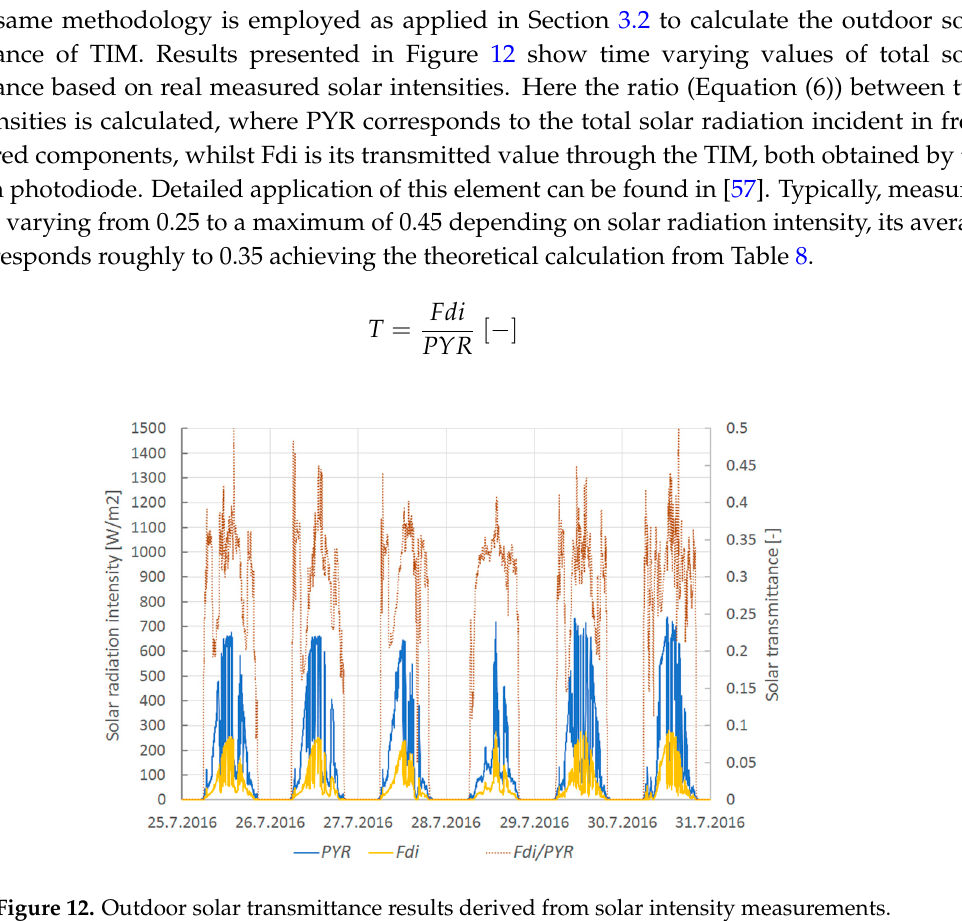
Figure 12. Outdoor solar transmittance results derived from solar intensity measurements.